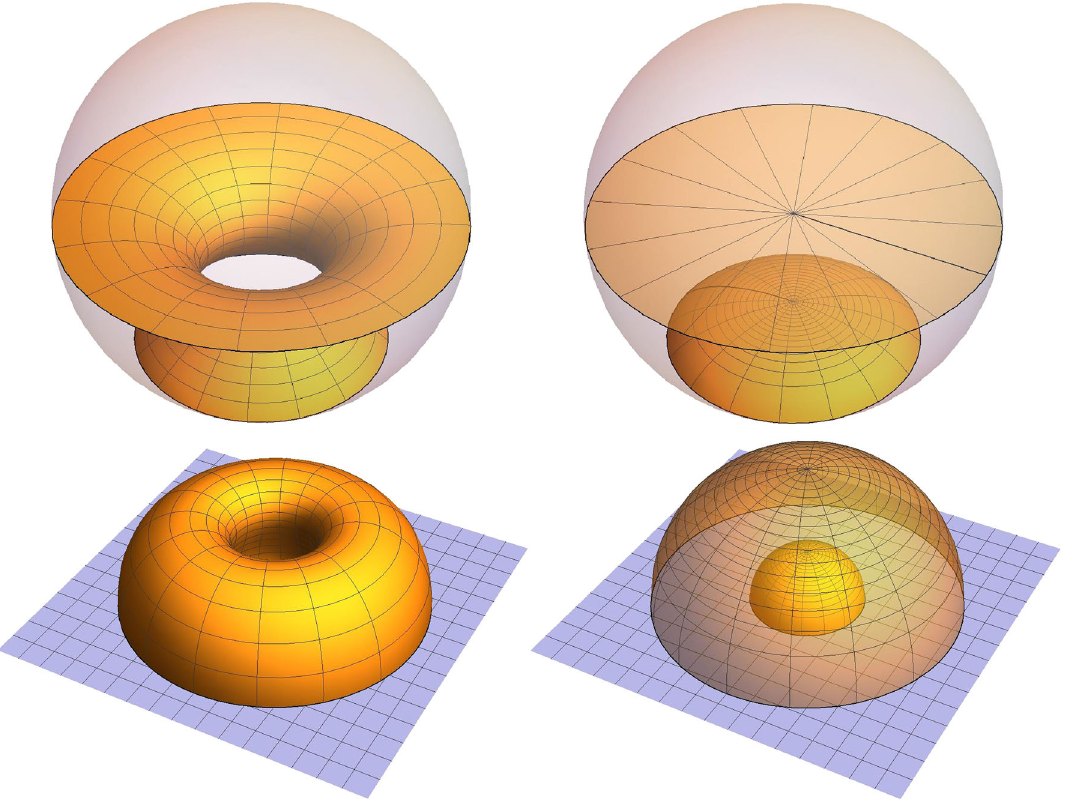
Fig. 14 A catenoid and a Goldschmidt minimal surface corresponding to the same boundary